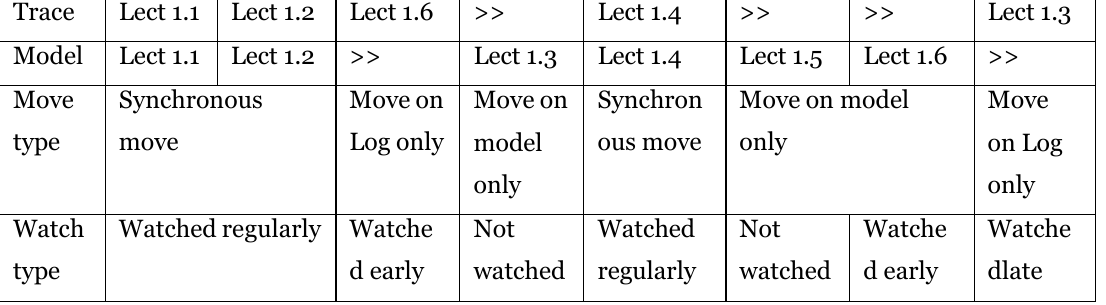
Example of an Alignment Calculated between an Observed Trace and an Expected Sequence From the Process